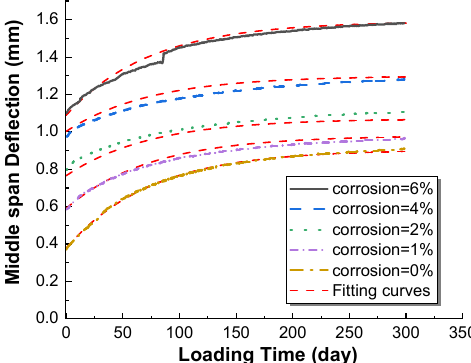
Figure 12. Fitting curves of equation model with different rust rates.